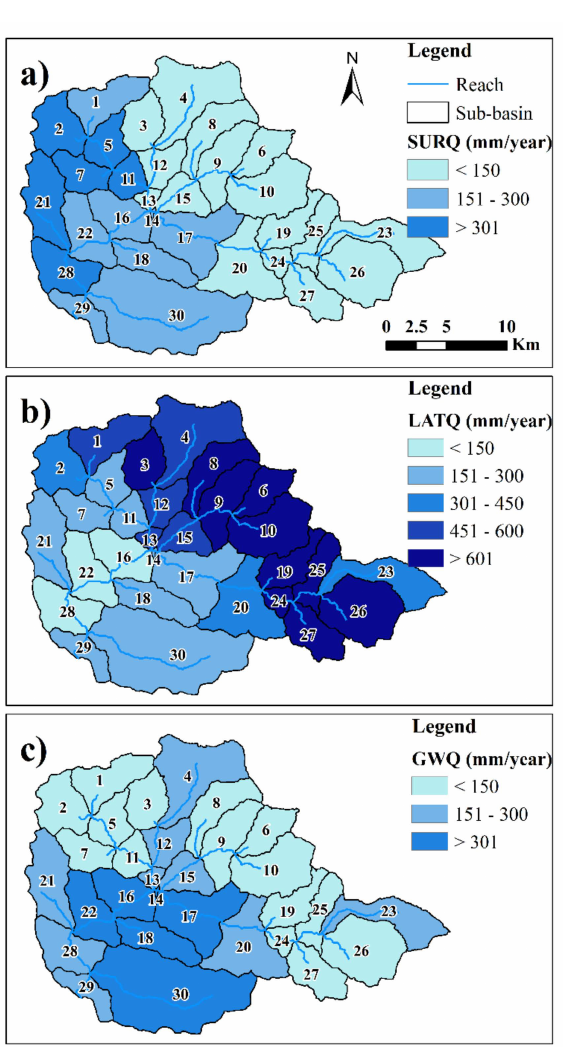
Figure 6. SWAT output maps of the surface flow ( a ); the lateral flow ( b ); and the groundwater flow ( c ). The values are expressed in mm per year between 1982 and 2013 with current land use of the Uberaba River